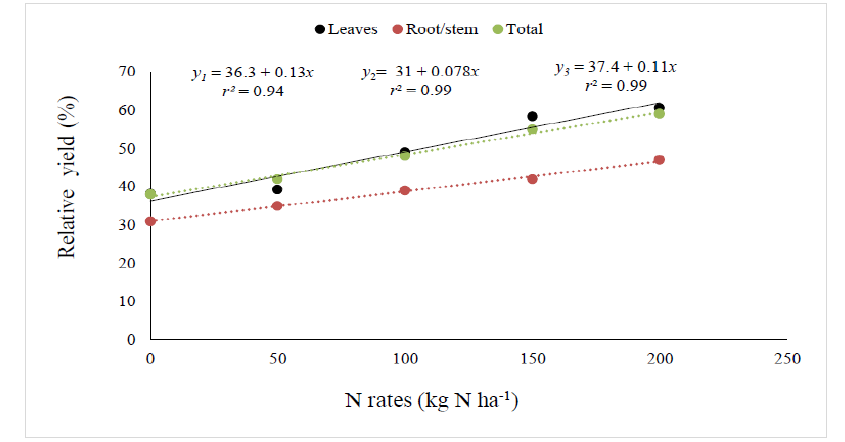
Figure 2. Regression model for relative leaf (y 1 ), root / stem (y 2 ), and total forage yield (leaf + root / stem, y 3 ) averaged across swede and kale a ff ected by di ff erent nitrogen (N) rates averaged across three environments in Prosper and Walcott, ND, USA in 2012 and 2014.